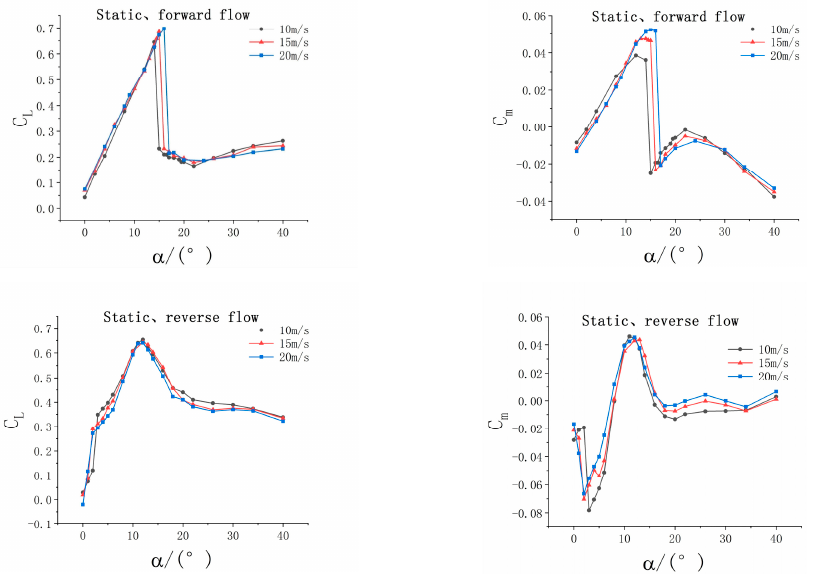
Figure 11. Lift coefficient and moment coefficient of static airfoil under forward-blowing and reverse-blowing.